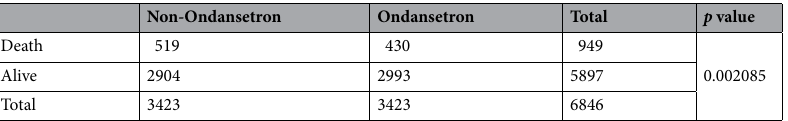
Table 2. The contingency table of the death events occurred in patients receiving/not receiving ondansetron. P-value is calculated with chi-square test.